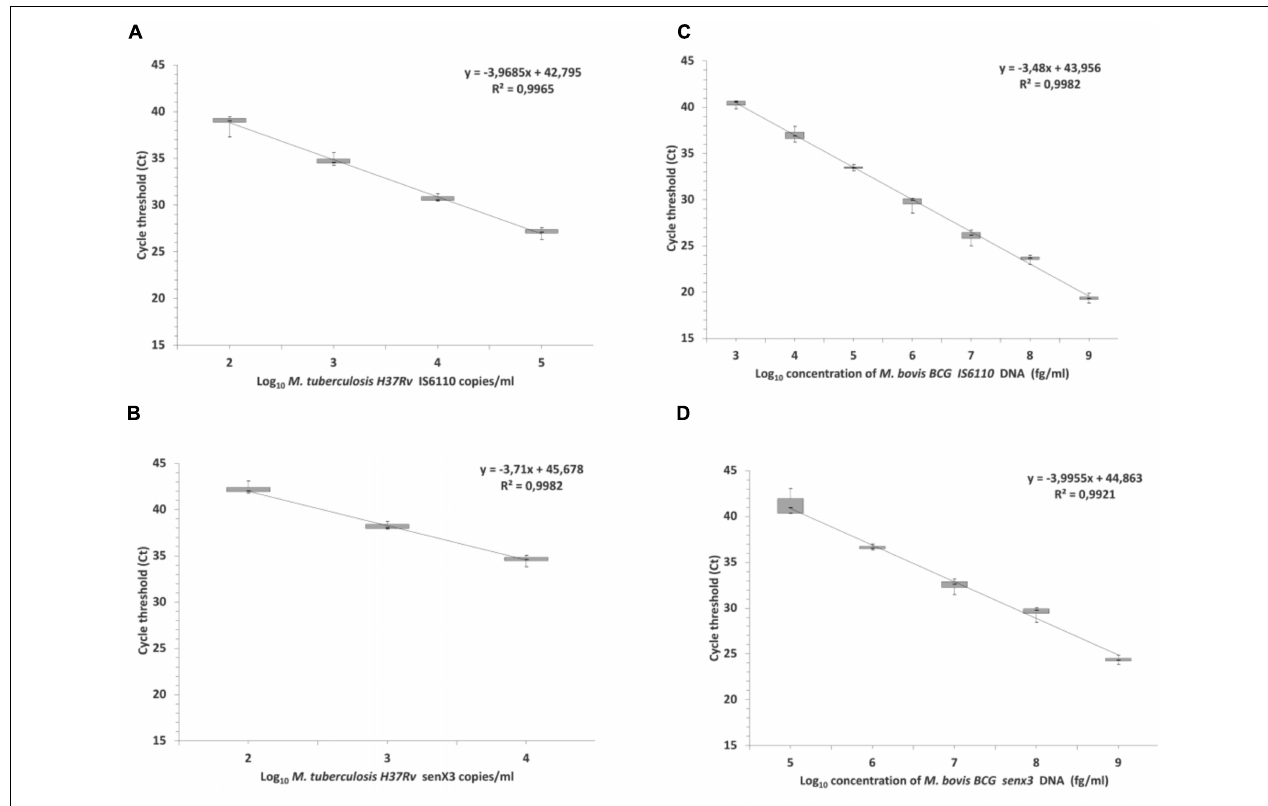
FIGURE 2 | Linearity of IS6110 (ISP) and senX3 qPCR. M. tuberculosis H37Rv commercial standard (A,B) and M. bovis BCG genomic DNA (C,D)